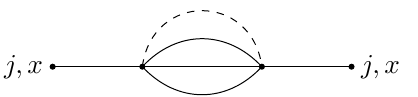
Figure 2. The leading order diagrams only connect fermions with same (cid:13)avor and spatial coordi- nate under random average of disorder (cid:12)elds (dashed line).